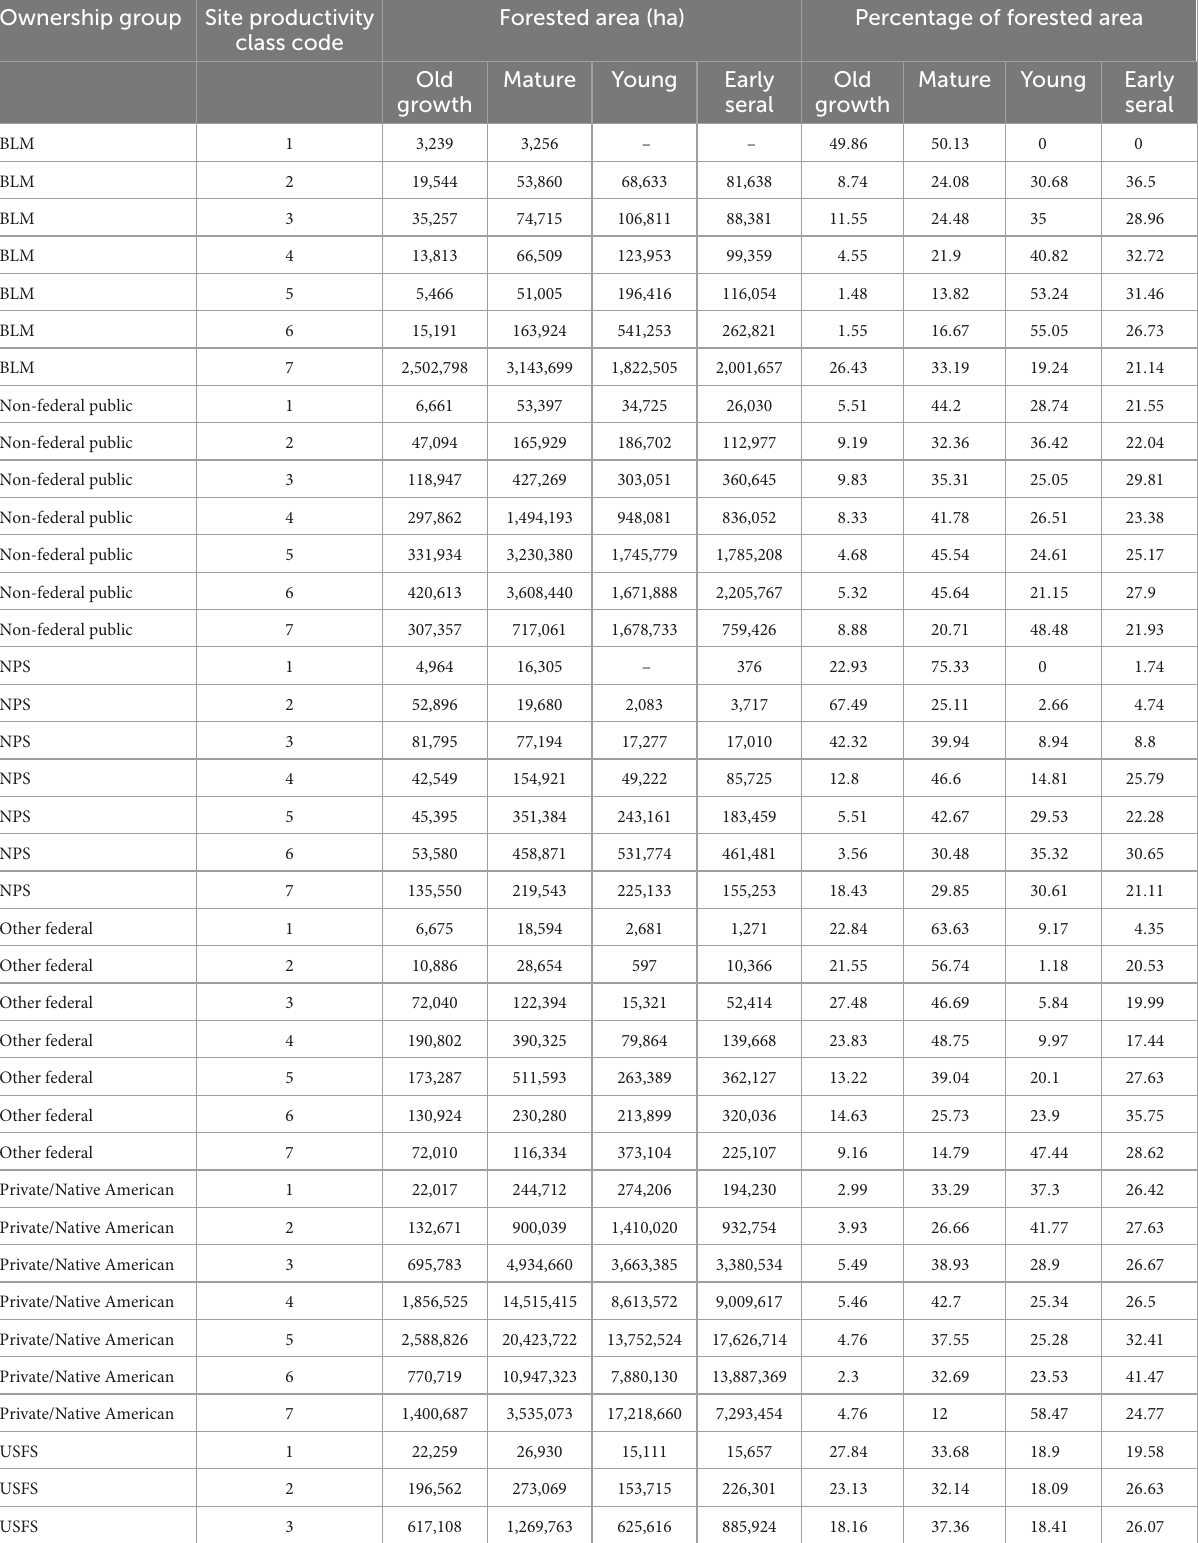
TABLE 5 Forested area and proportion of total forested area summarized by stand development phase, site productivity class code, and ownership group. Ownership group Site productivity class